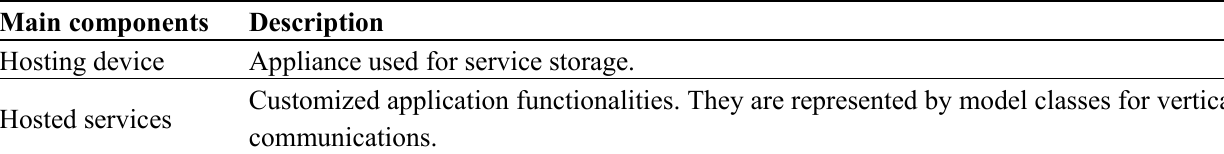
Table 6. Description of IEC 61850 and DPWS main